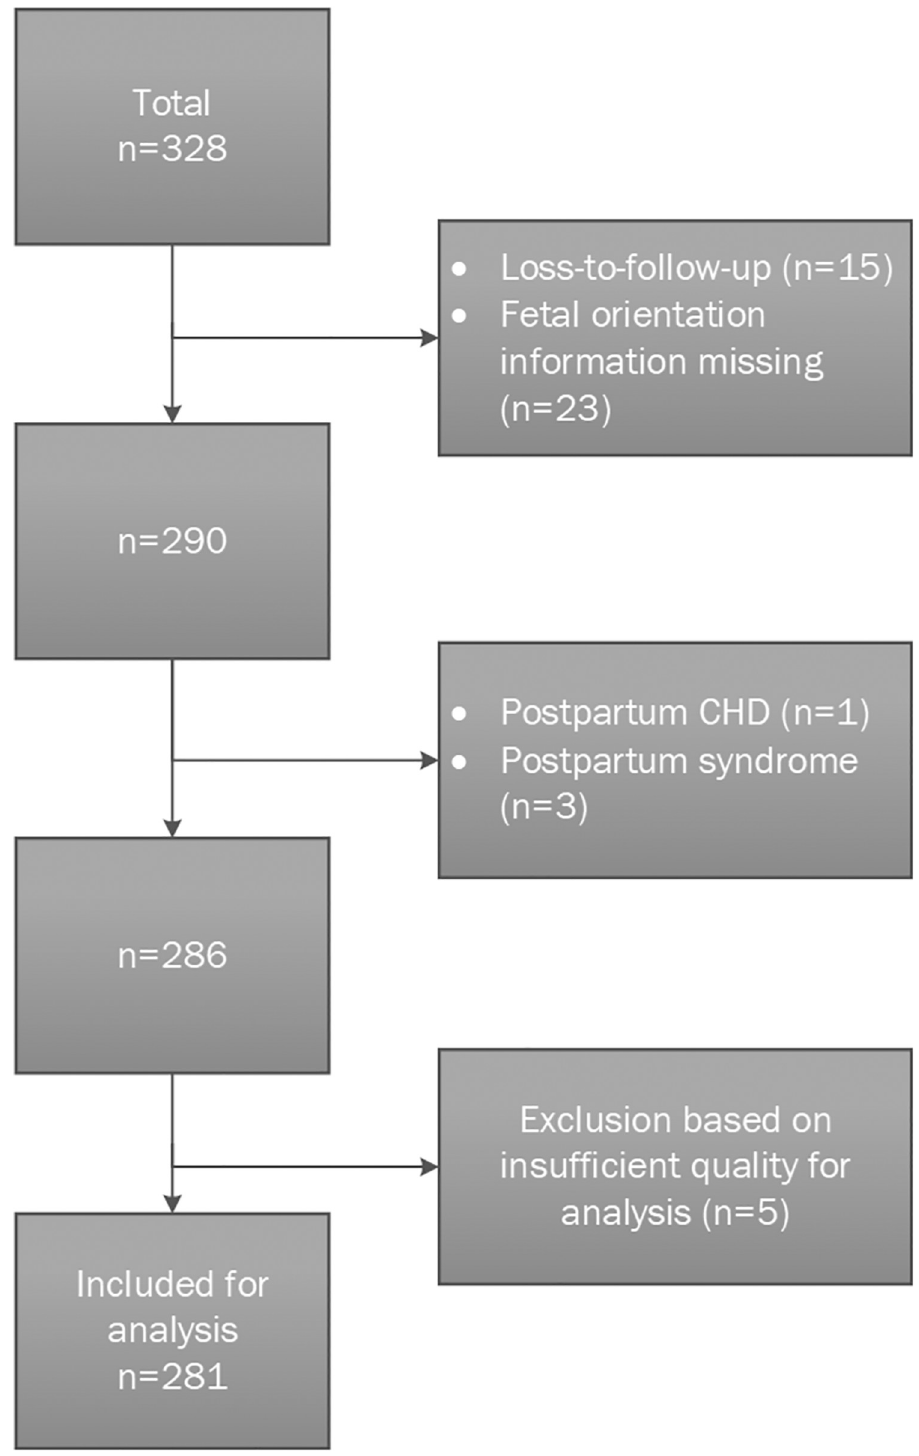
Fig 2. Flowchart of the included